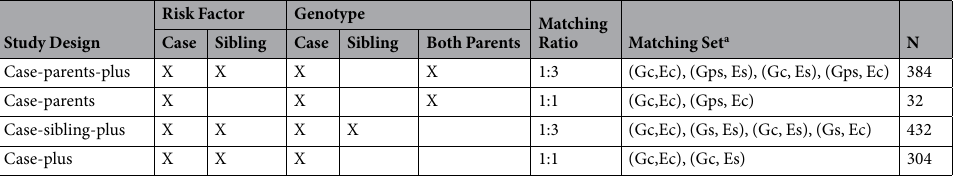
associated with the risk factors. The matching sets used in CLR for the four family structures in our data are summarized in Table 1. More specifically, for case-parents-plus and case-sibling-plus families, each case was matched with 3 other hypothetical genotype/risk-factor combinations: (1) her sister’s actual genotypes and risk factors; (2) her own